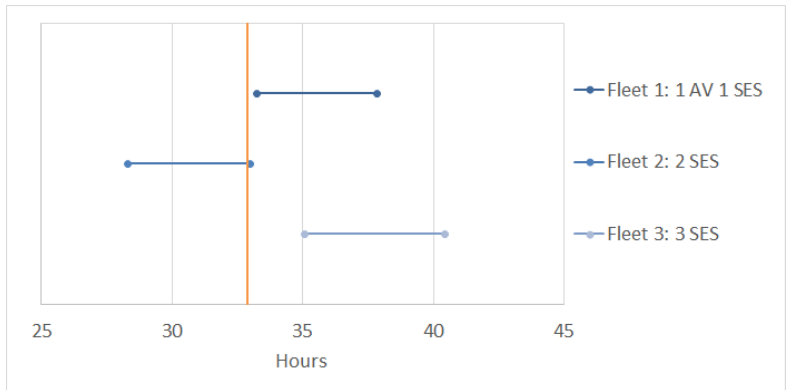
Figure 5. Ninety-five percent confidence intervals of the hours of preventive maintenance performed during the simulation period by the three different vessel fleets. The orange line represents the average hours of preventive maintenance that must be performed during the simulation period in order to complete all yearly preventive tasks.